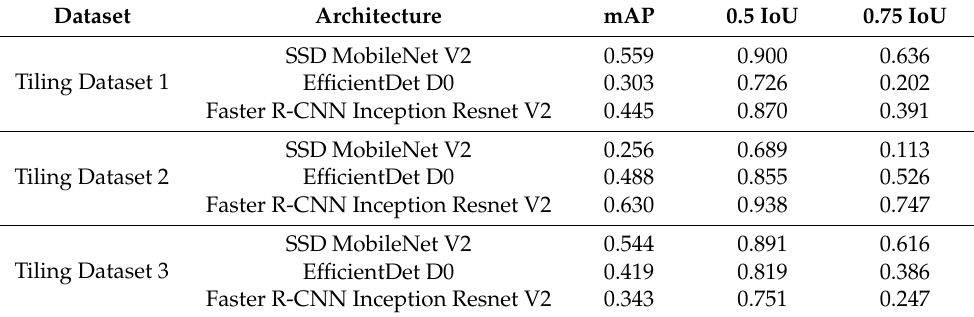
Figure 12. SSD MobileNet V2 model prediction on example images using Test Dataset 3 of ( a ) the same image of Test Dataset 1 and ( b ) the same image of Test Dataset 2. Table 7. The object detection evaluation on the Tiling ACF Dataset.